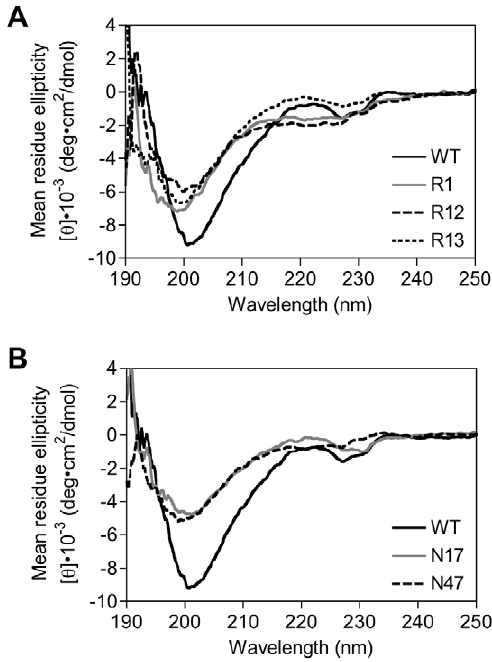
Figure 7. Circular dichroism spectra of selected proteins. (A) The mean residue ellipticity values of wild-type SH3 domain (black solid line) and SH3 variants R1 (gray solid line), R12 (dashed line) and R13 (dotted line) selected from the SH3(RNN) 28 library are shown. (B) The mean residue ellipticity values of wild-type SH3 domain (black solid line) and SH3 variants N17 (gray solid line) and N47 (dashed line) selected from the SH3(NNN) 28 library are shown.